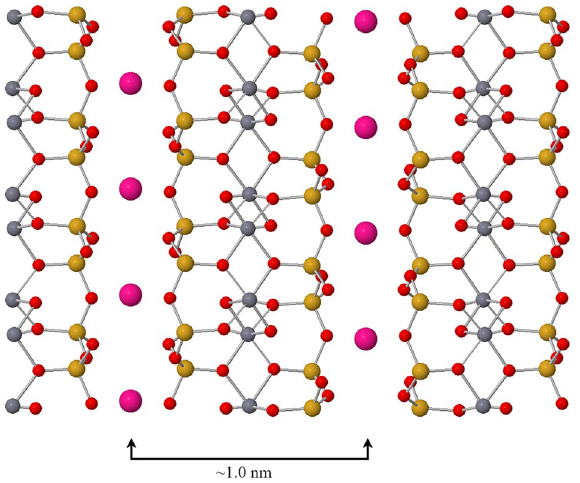
Figure 1. Model of the crystal structure of muscovite mica. The elements are colour coded Red = Oxygen, Grey = Aluminium, Pink = Potassium and Yellow = Silicon. Each mica sheet consists of an aluminium octahedron layer (aluminium, oxygen, hydrogen) sandwiched between two tetrahedron layers (silicon, aluminium, oxygen). Three sheets of mica are shown and potassium ions intercalate in-between these sheets. The mica cleaves readily between the potassium ion planes yielding a step height on exfoliation of 1.0 nm. The model is generated based on the reported literature 24